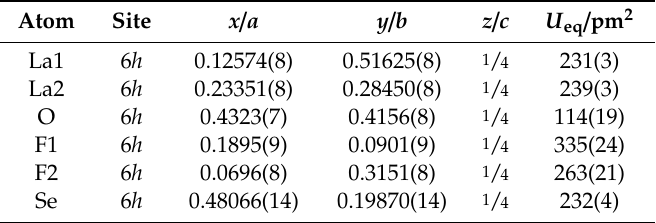
Table 3. Fractional atomic coordinates and U eq values a for B-La 2 OF 2